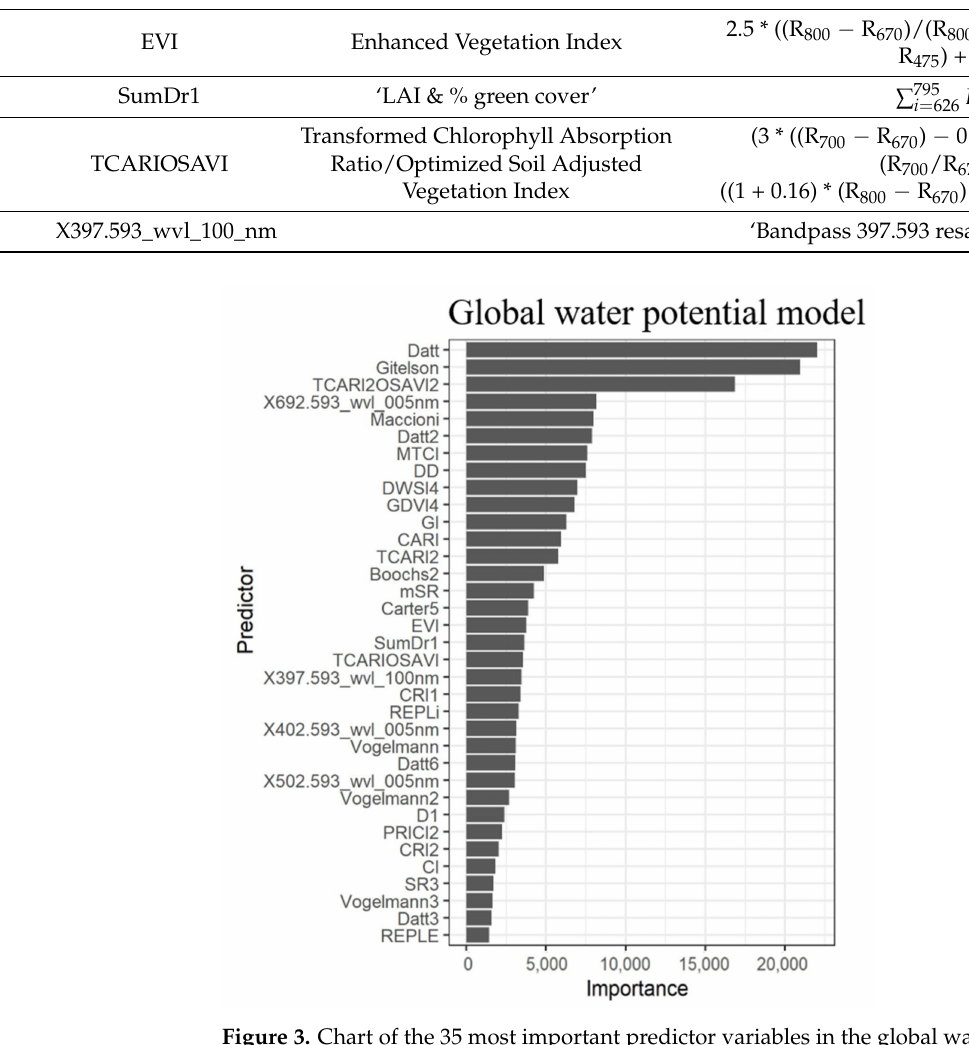
Figure 3. Chart of the 35 most important predictor variables in the global water potential model, the first 20 of which were included in the selected classifier, and corresponding importance levels.